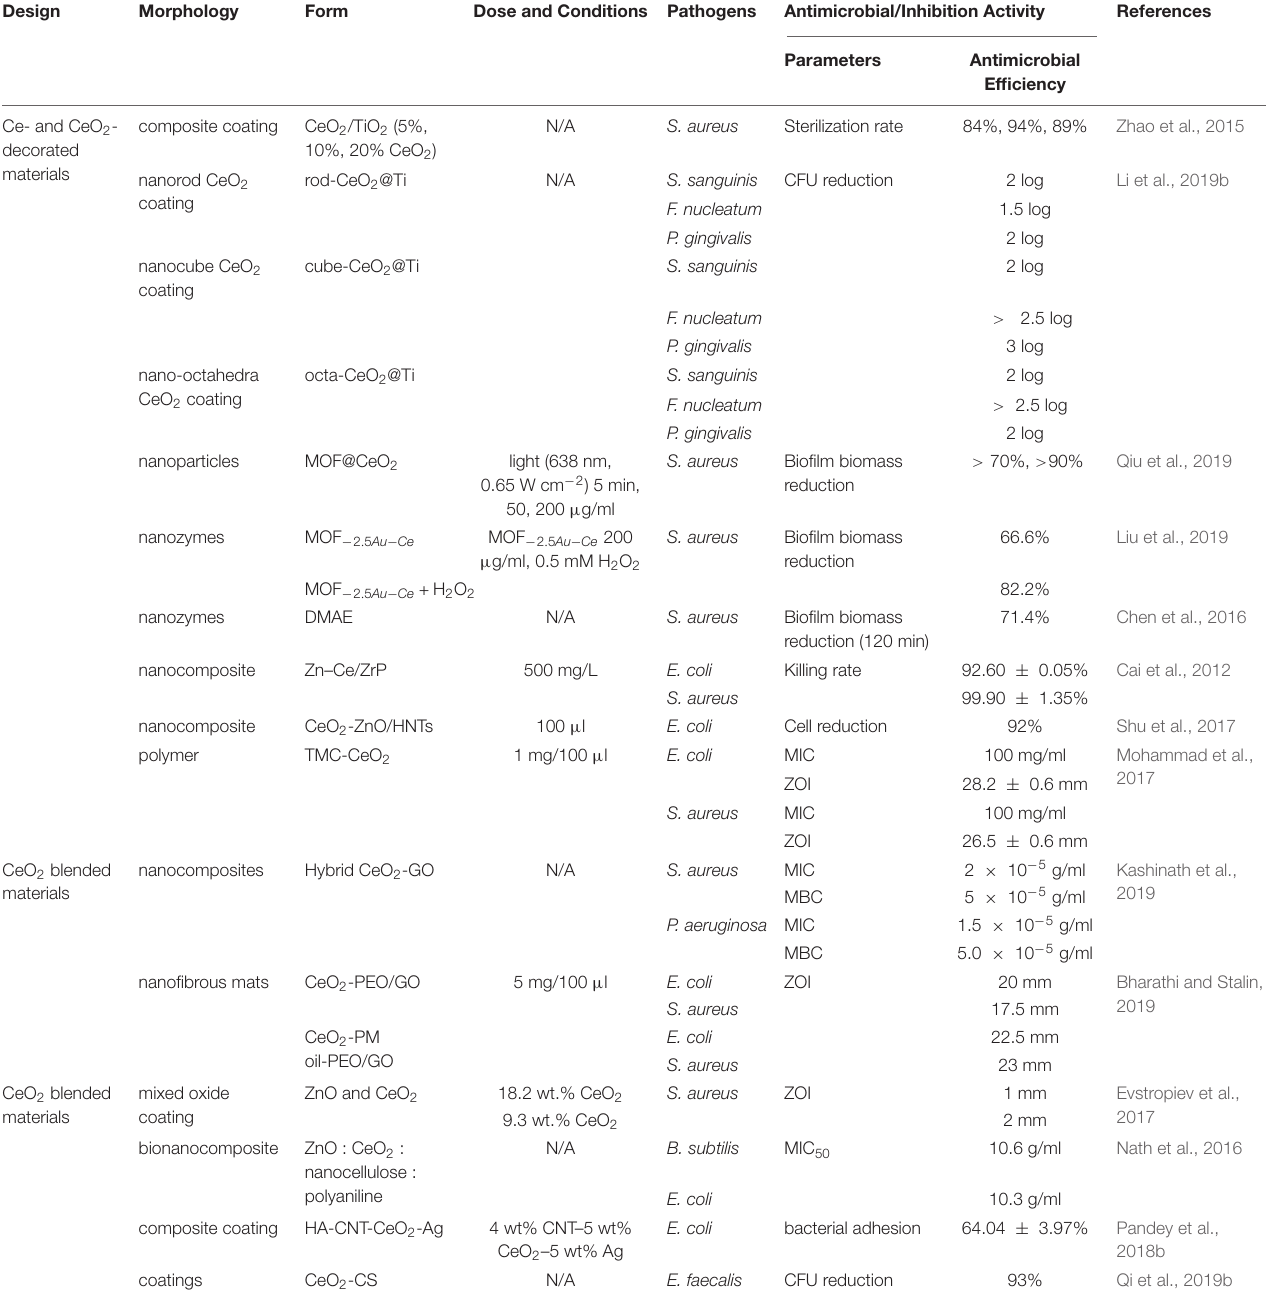
TABLE 4 | The antibacterial activities of cerium- and cerium oxide-decorated/blended materials.